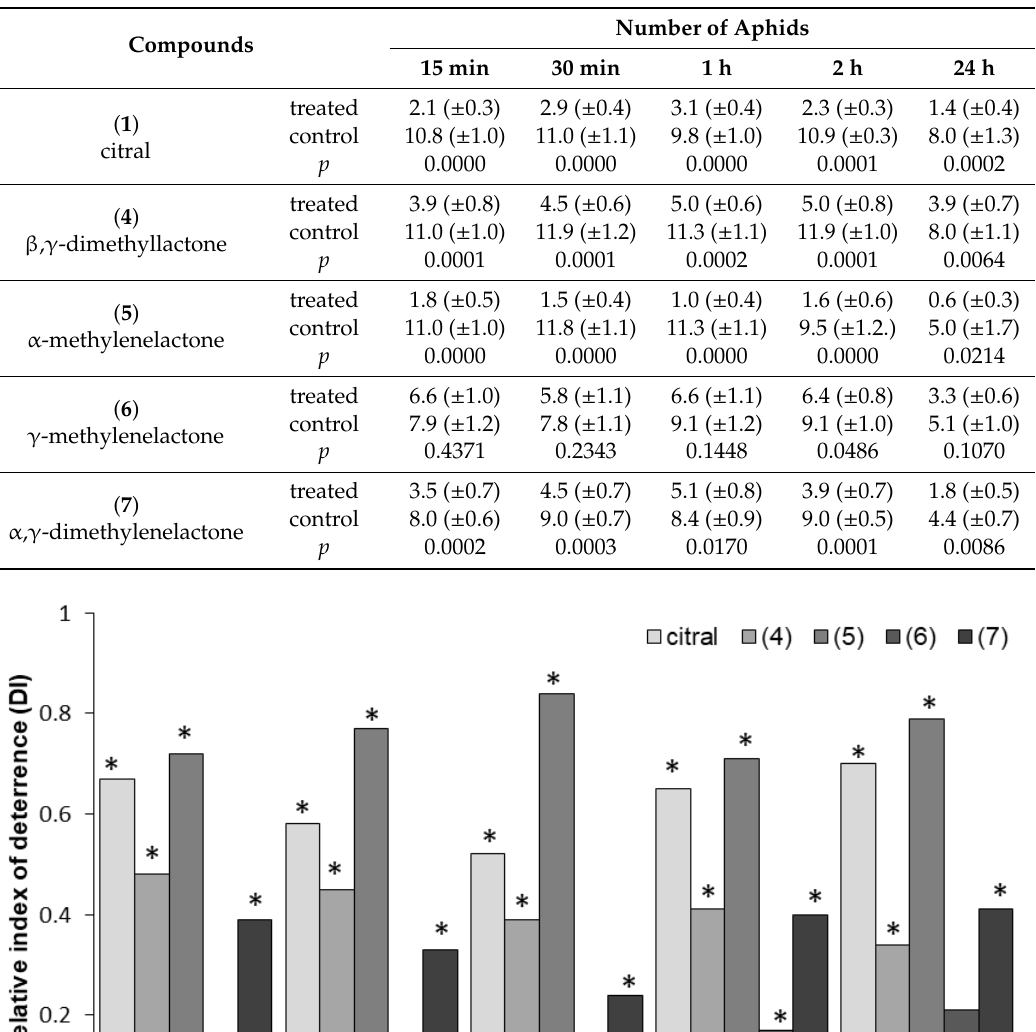
Table 1. E ff ect of citral and citral-derived lactones on the settling behavior of Myzus persicae . Aphids had free access to treated and untreated half-leaf sections for 24 h. Numbers represent mean ( ± SE) number of aphids that settled on treated (T) and untreated control (C) halves of the leaves at 15 and 30 min and 1, 2, and 24 h after aphids had access to the leaves; n = 8 (20 aphids per replicate); p < 0.05 denotes statistically significant di ff erences (Student t -test).